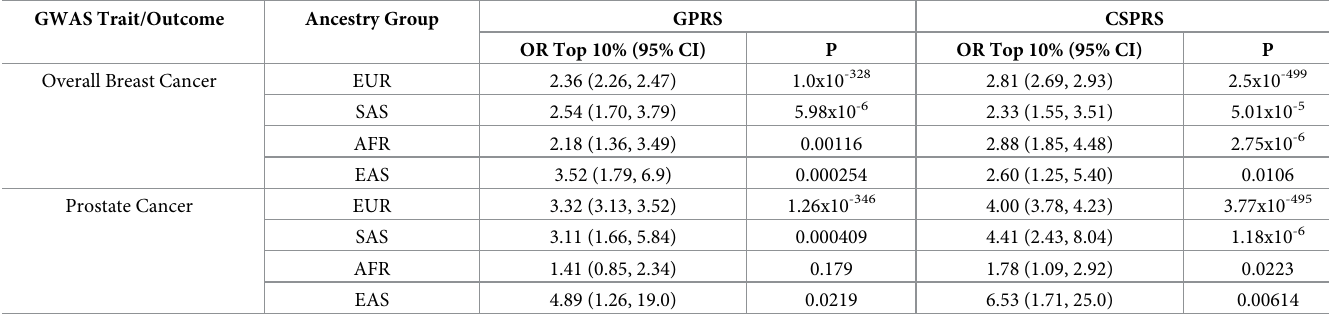
Table 2. Case enrichment in breast and prostate cancer PRS top 10% versus bottom 90%. GWAS Trait/Outcome Ancestry Group GPRS Overall Breast Cancer